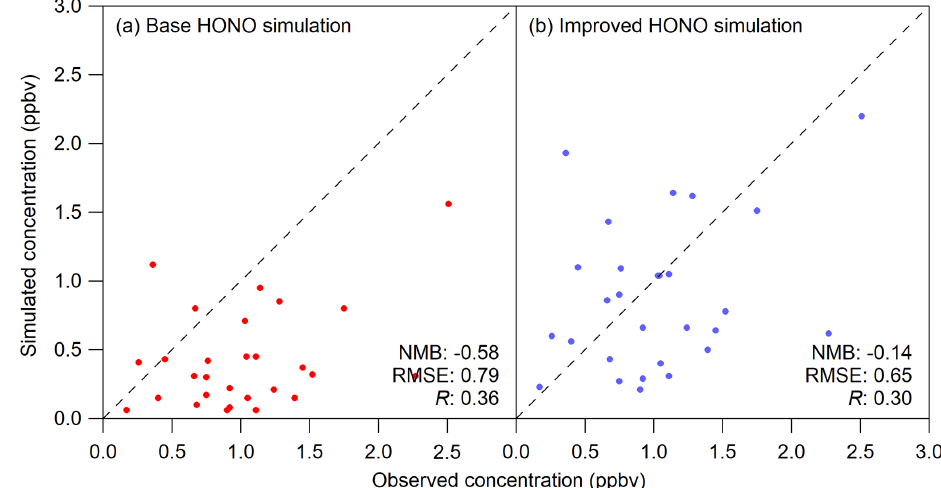
Figure 3. Scatterplots of the observed campaign-average mixing ratios of HONO and those simulated by (a) the Sp_base simulation and (b) the Sp_R1 + 2 simulation. Note that the HONO mixing ratios in the Sp_base, Sp_R1, Cp_base, and Cp_R1 simulations are